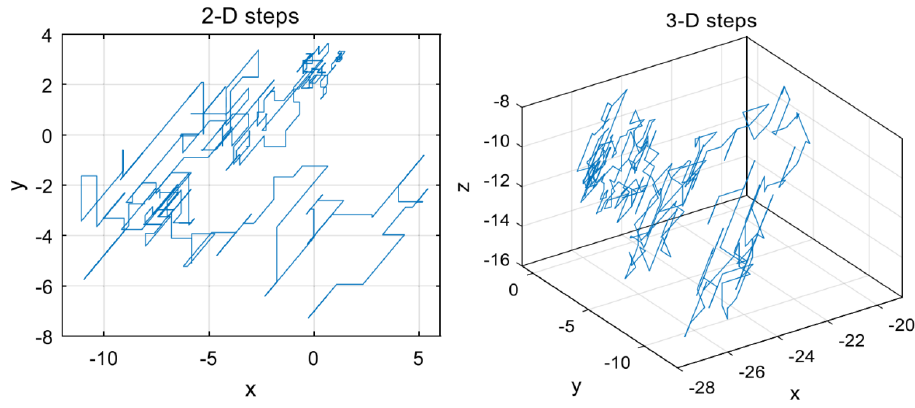
Figure 4. Trajectory of 300 steps of the running operator [37].